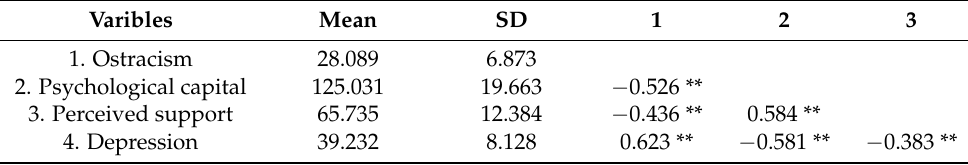
Table 1. Mean, standard deviations, and correlations among variables.